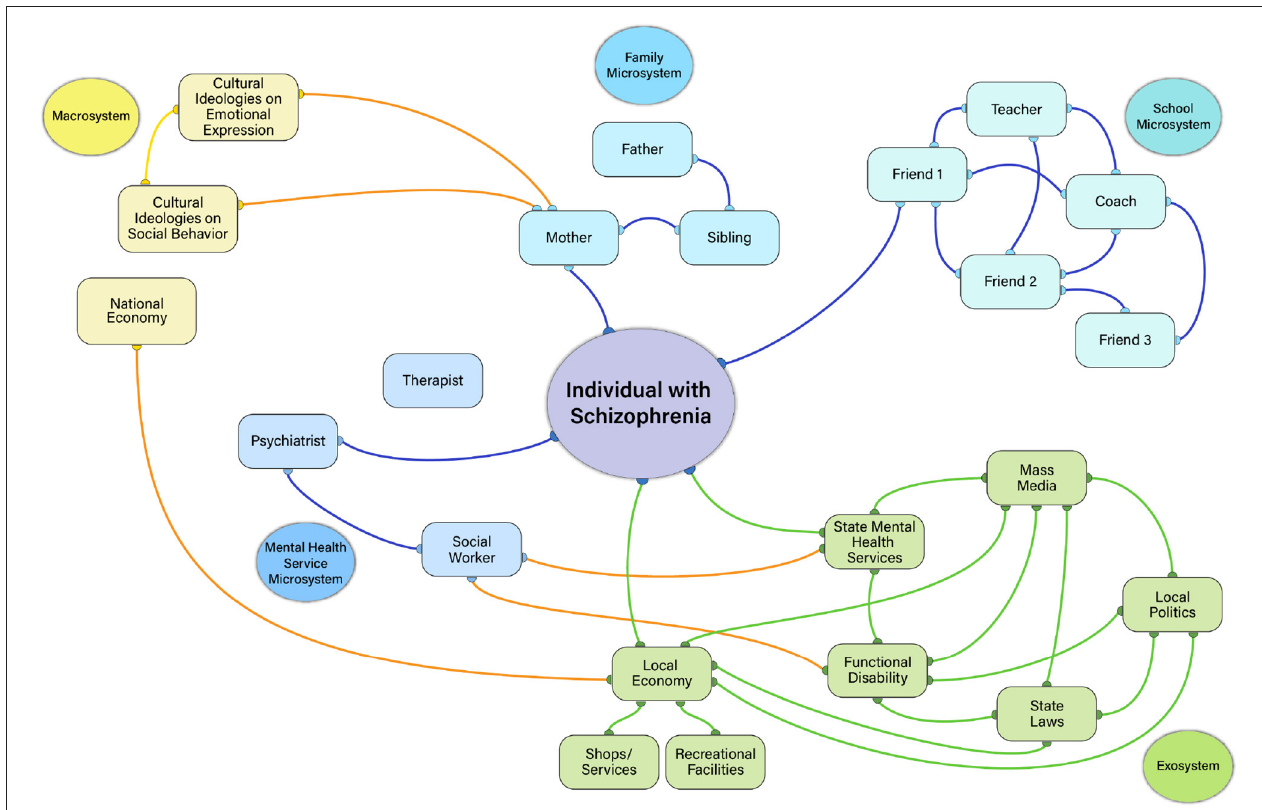
FIGURE 3 | High negative symptom ecosystem network illustration. In this example, imagine an 18 years old male who is in the first episode of schizophrenia with high negative symptoms. Just like the example in Figure 2 , he has three prominent microsystem settings: home, school, mental health services. However, unlike the low negative symptom example in Figure 2 , he is not densely connected to the people and places within these settings (note fewer orange lines within microsystems). He interacts with his mother, but does not interact with his father and brother, even though his mother, father, and brother all interact with each other. Unlike Figure 2 , there is no highly central figure helping to make connections across microsystems (i.e., the mesosystem has low density- note the absence of yellow lines). As a result, he is less likely to engage in as many close social interactions or recreational activities with his peers or family. He has a psychiatrist, but is not connected with a therapist or social worker to coordinate care. The mental health professionals in the local mental health setting are also generally less connected to each other and functioning independently. As such, he is not receiving the same quality of care as the patient in Figure 2 and is less motivated to receive treatment. He has stopped going to school. He maintains contact with one friend from school, who has connections to other friends of their own, teachers, and coaches. But, the individual themselves no longer maintains ties with those in the school setting beyond the one friend. At the exosystem level, the patient lives in poverty stricken area with few resources (shops, recreational facilities), high levels of crime, and poor transportation access. These factors contribute to less socialization, recreational activities, and goal-directed activities. He receives disability benefits and has just enough money to live in a subsidized group home, but not enough to socialize frequently or pursue recreational activities. Local politics and state laws/policies influence details related to the disability benefits, subsidized housing, and mental health services the patient receives. Yellow, Macrosystem; Green, Exosystem; Light Blue, Microsystem; Dark Blue, Mesosystem; Orange, cross-system interactions; Purple, Person-Level